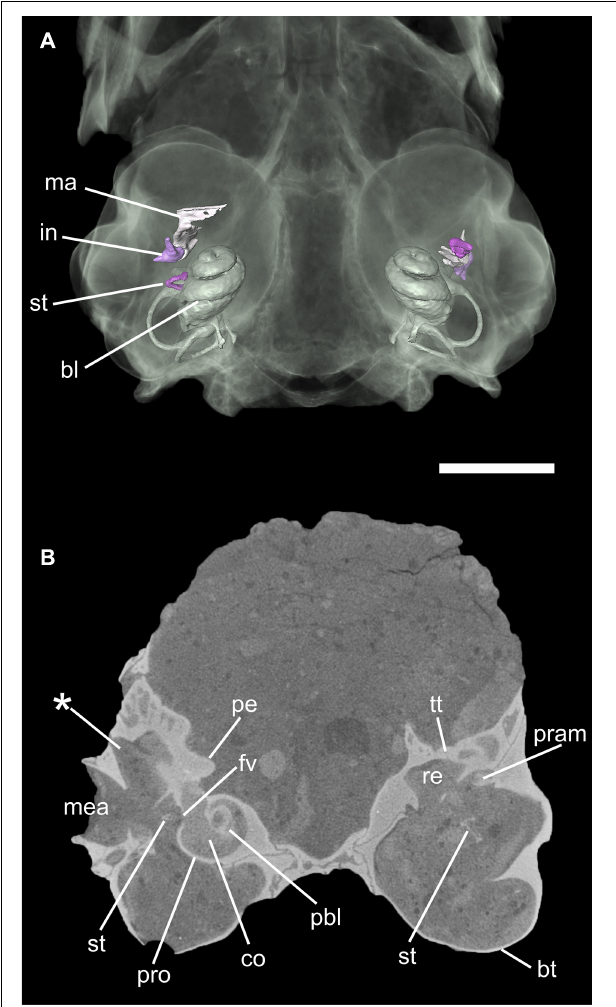
FIGURE 3 | Virtual 3D reconstruction of the auditory region of Palaeolagus haydeni (FMNH PM9476) in ventral views (A) . The skull bones are transparent in order to show the auditory ossicles and bony labyrinth. (B) transversal µ CT image through the auditory region. Note the small processus anterior (pram) of the malleus below the tegmen tympani in the left ear. The asterisk (*) indicates the lateral expansion of the epitympanic recess. Abbreviations: bl, bony labyrinth; bt, bulla tympani; co, cochlea; re, epitympanic recess; fv, fenestra vestibuli; in, incus; ma, malleus; mea; meatus acusticus externus; pbl, primary bony lamina; pe, petrosal; pram, processus anterior of malleus; pro, promontorium; st, stapes; tt, tegmen tympani. Scale bar = 5